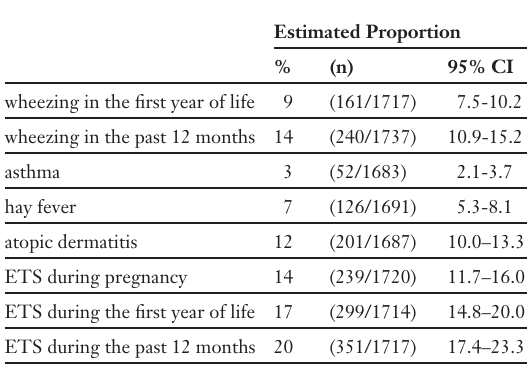
Estimated prevalence (%) and 95% confi- dence intervals (95% CI) of symptoms and environmental tobacco smoke exposure (ETS) in our sample.